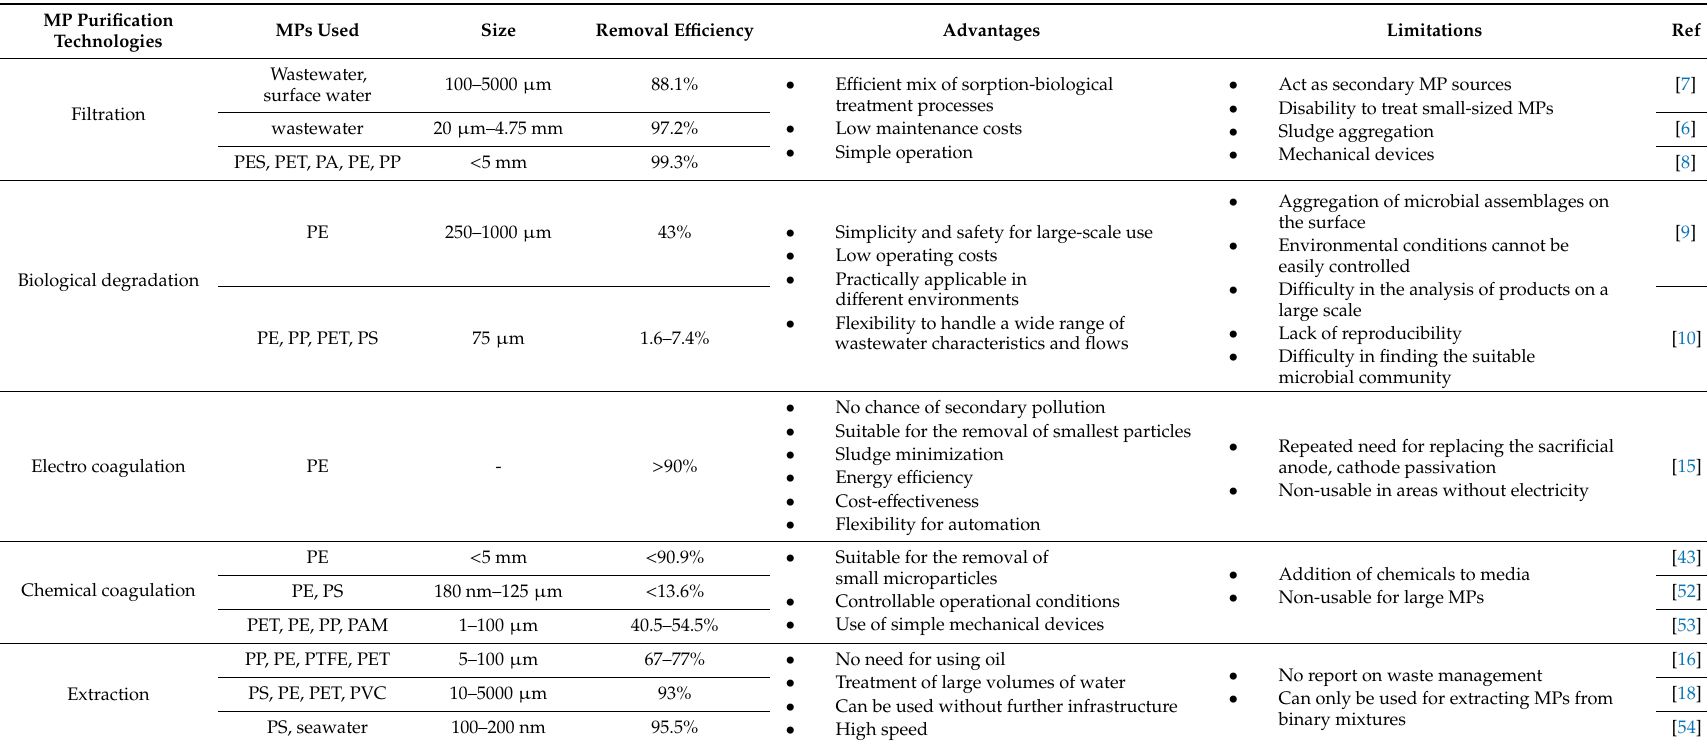
Table 1. A summary of MP purification